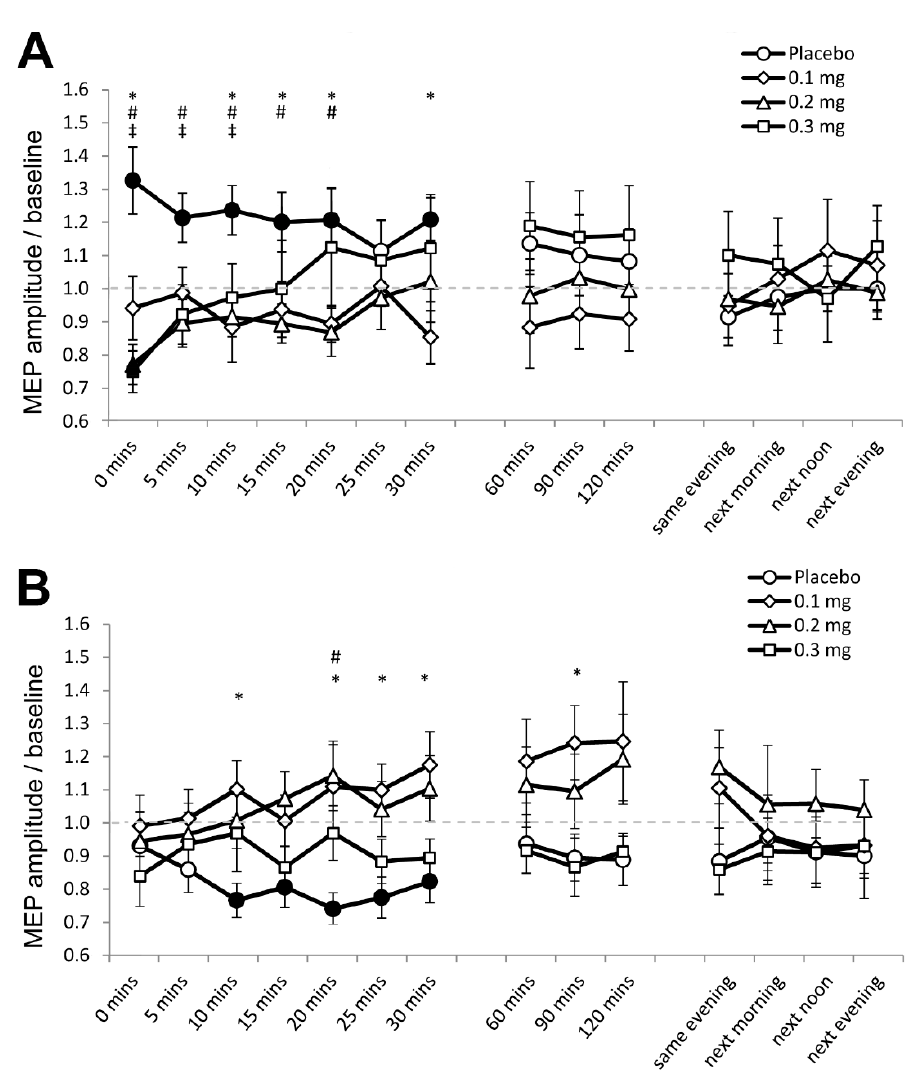
Figure 2. Effects of apomorphine on nonfocal plasticity induced by anodal and cathodal tDCS (Experiment 1). The x -axis displays the time points (in minutes) of post-stimulation measurements. The y -axis displays the mean MEP amplitudes after stimulation (MEPs were standardized to the corresponding baseline values for each participant). The graphs show that under placebo medication anodal tDCS enhanced excitability, and cathodal tDCS diminished excitability for ∼ 30 min after stimulation. ( A ) Low-dose (0.1 mg) abolished, medium-dose (0.2 mg) and high-dose (0.3 mg) transiently reversed the after-effect of anodal tDCS. ( B ) All dosages of apomorphine abolished the after-effect of cathodal tDCS. Filled symbols indicate statistically significant deviations of the post-tDCS MEP values compared with baseline. *, # and ‡ symbols indicate significant differences of the real medication compared with the placebo medication conditions at the same time points after plasticity induction (Bonferroni corrected, two-tailed, paired t -test, p ≤ 0.05). Error bars show standard error of mean (SEM). * 0.1 mg of apomorphine, # 0.2 mg of apomorphine, and ‡ 0.3 mg of apomorphine.